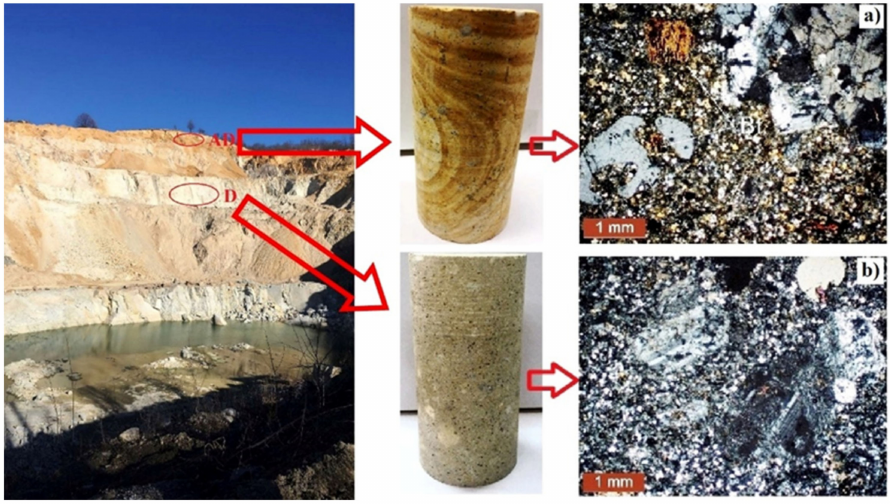
Figure 2. Analyzed open pit slope consisting of dacite with microscopic images of the material: ( a ) altered dacite and ( b )